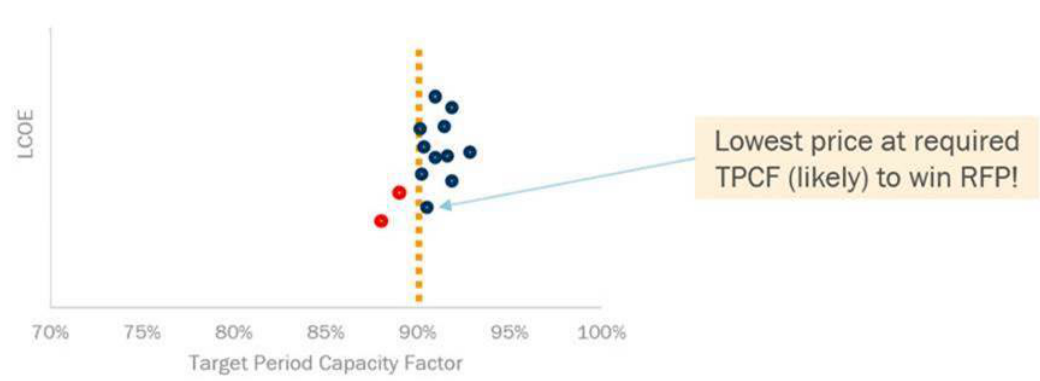
Figure 5. An example of LCOE vs TPCF portraying different technologies, system sizes and configurations which meet the TPCF requirement of 90% which is specified in the request for proposals (RFP). Source: First Solar PVS Analytics.